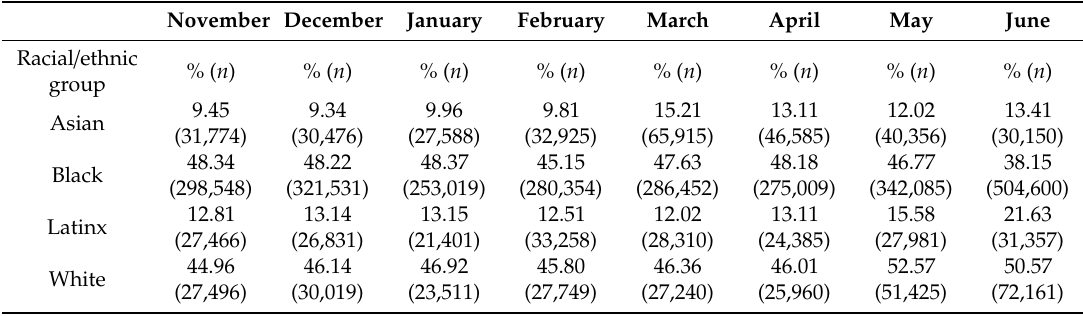
Table 1. Percent of tweets referencing racial and ethnic groups that are negative by month, November